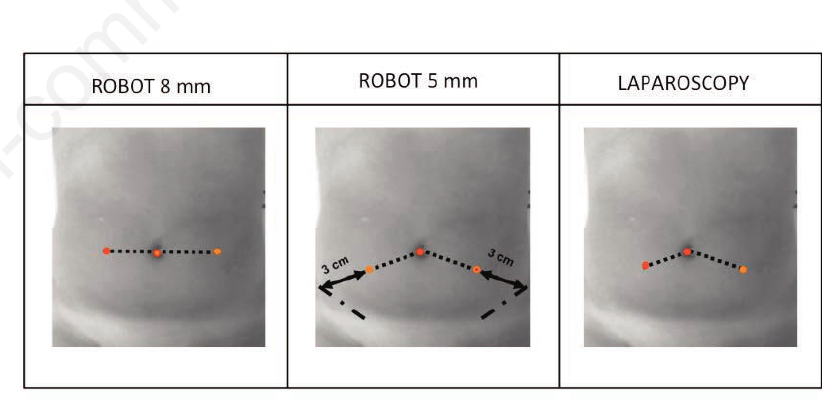
Figure 2. Port placement in minimally invasive